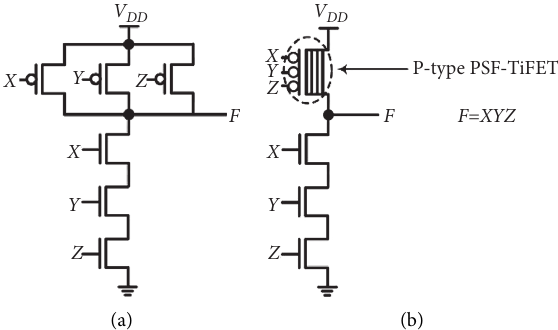
Figure 15: The three-input NAND gate using (a) the single-input device, and (b) the PSF-TiFET device. 0.8